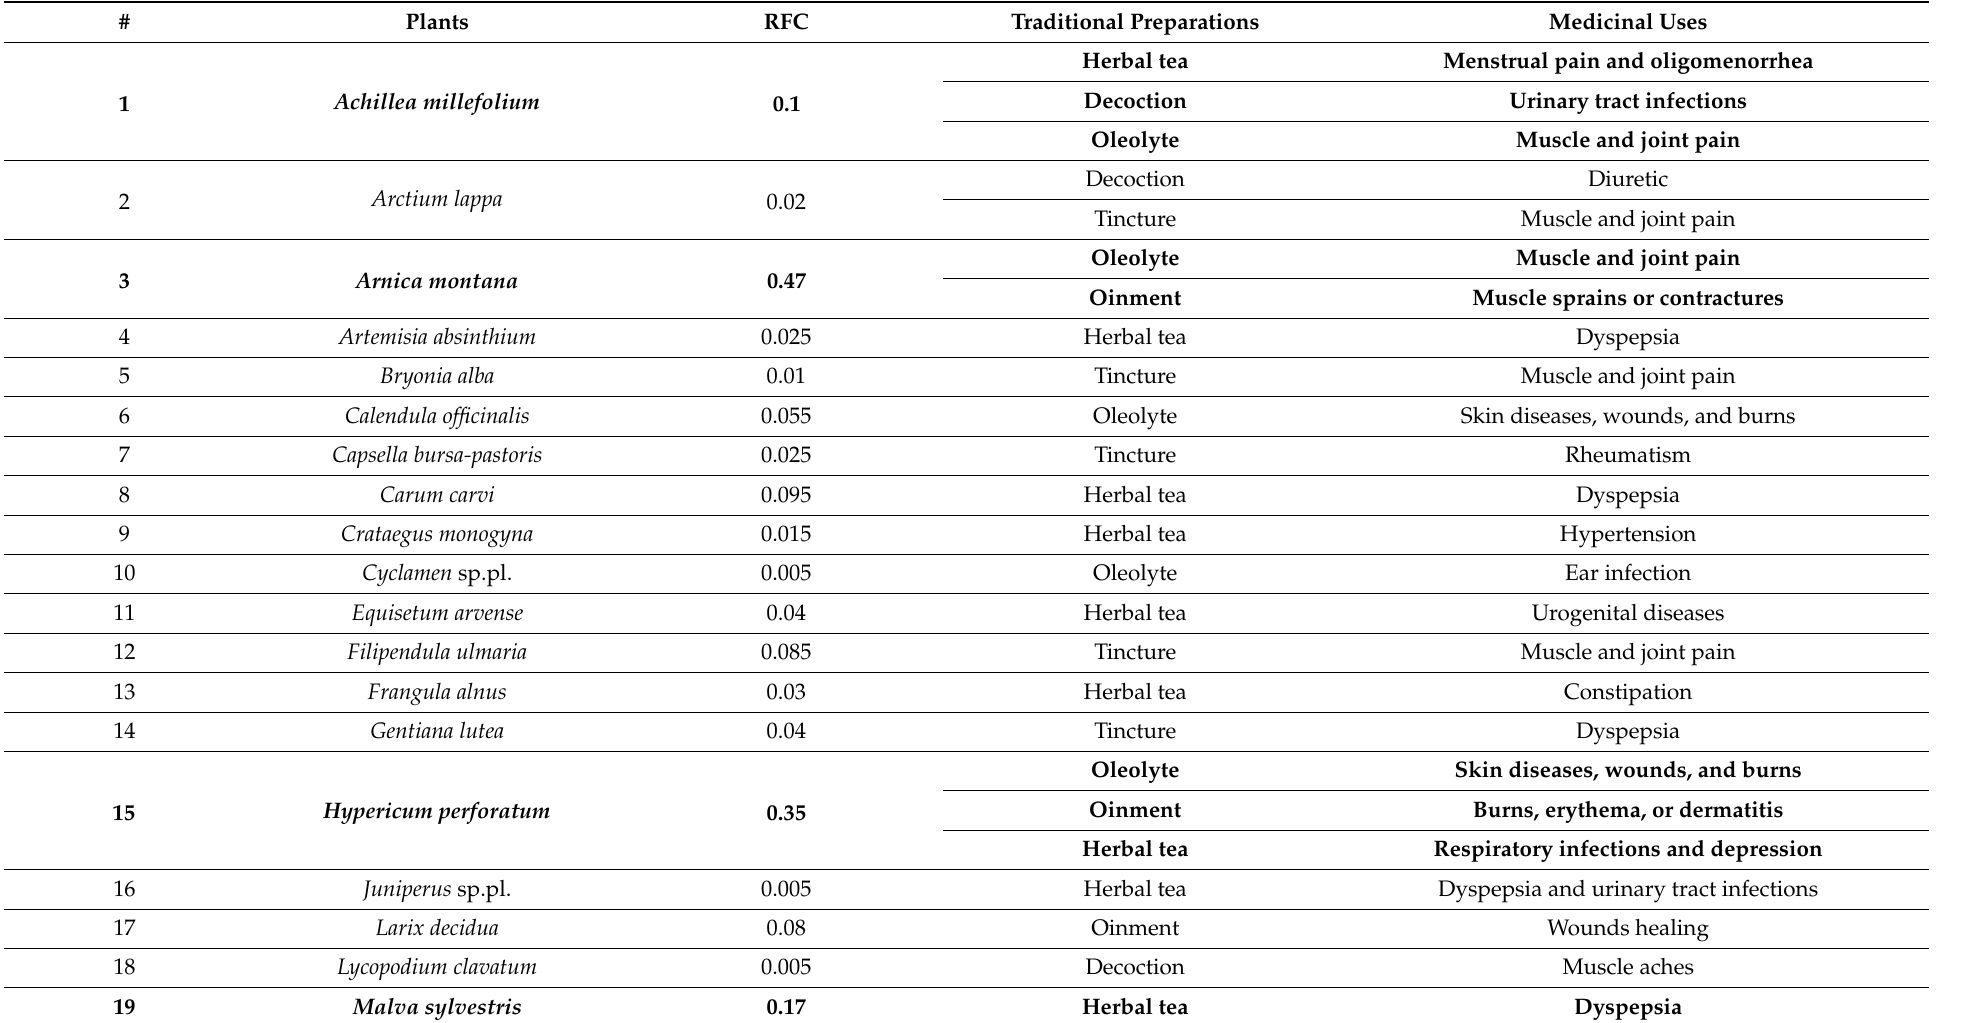
Table 5. Plants mainly used for traditional preparations and related RFC values and medicinal